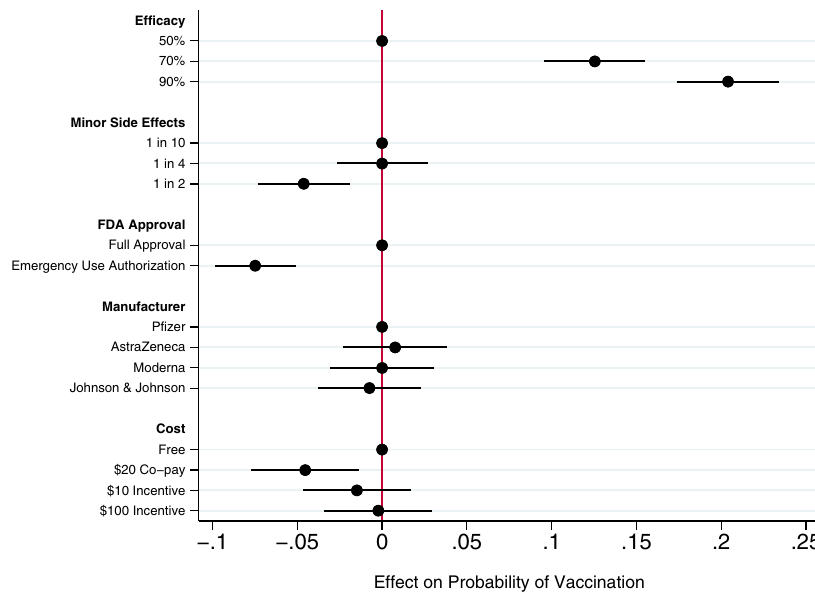
Fig. 1 Effects of vaccine attributes on willingness to vaccinate. Circles present the estimated effect of each attribute level on the probability of a subject accepting vaccination from the attribute ’ s baseline level. Horizontal lines through points indicate 95% con fi dence intervals. Points without error bars denote the baseline value for each attribute. The average marginal component effects (AMCEs) are the regression coef fi cients reported in model 1 of Table